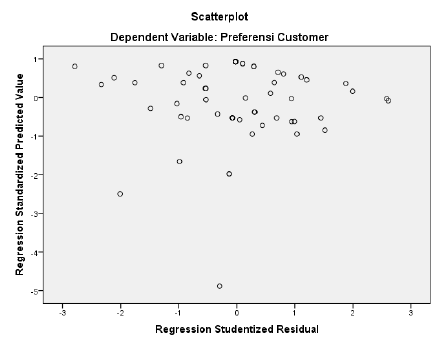
Fig. 5 Scatterplot of heteroscedasticity test from customer respondents